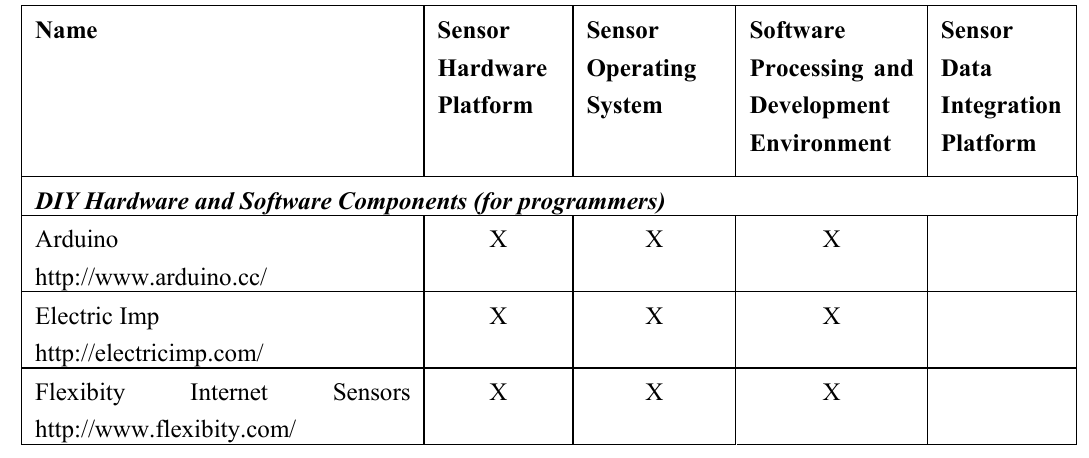
Table 1. Selected Examples of Emerging Solutions in the IOT